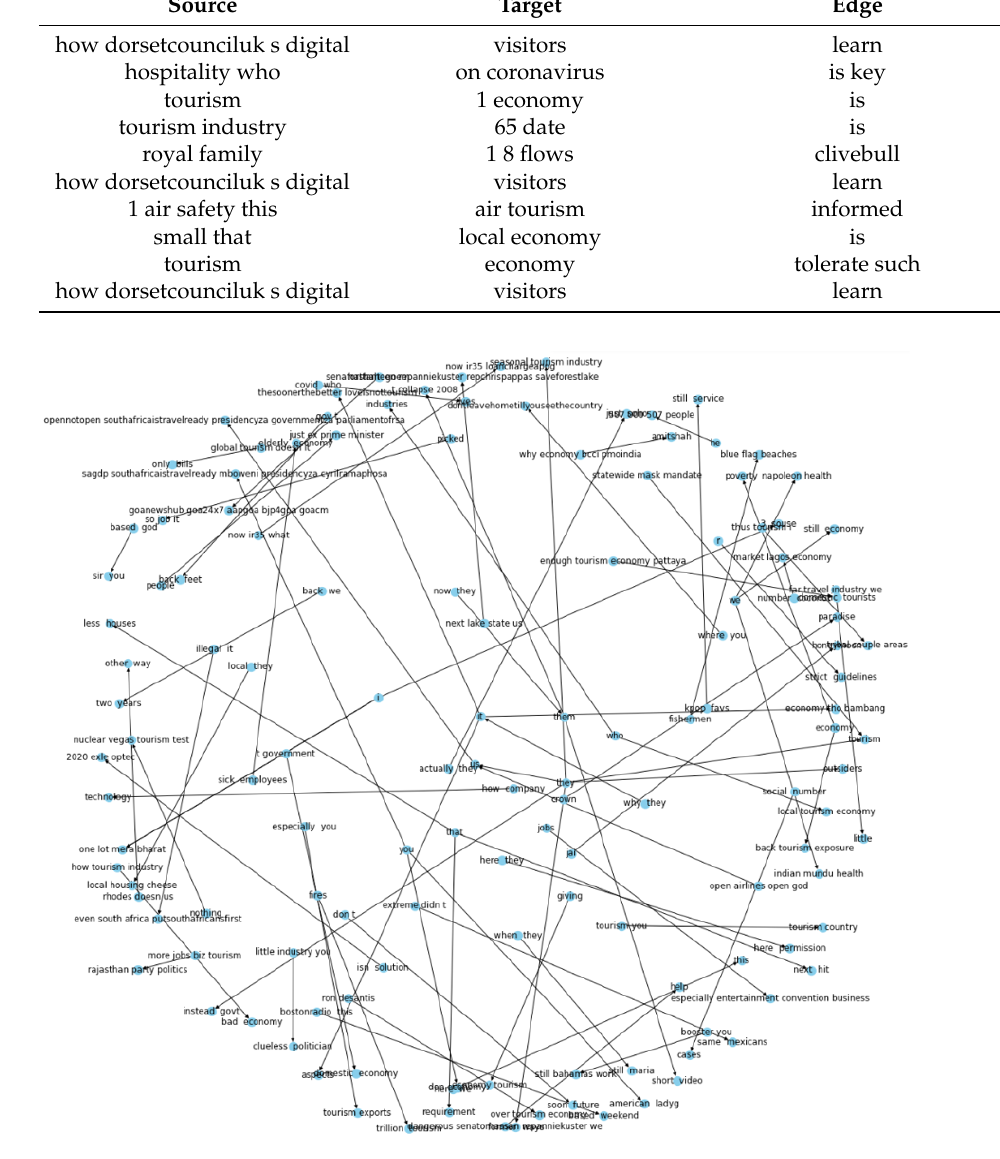
Figure 20. Knowledge Graph for Cluster 1.